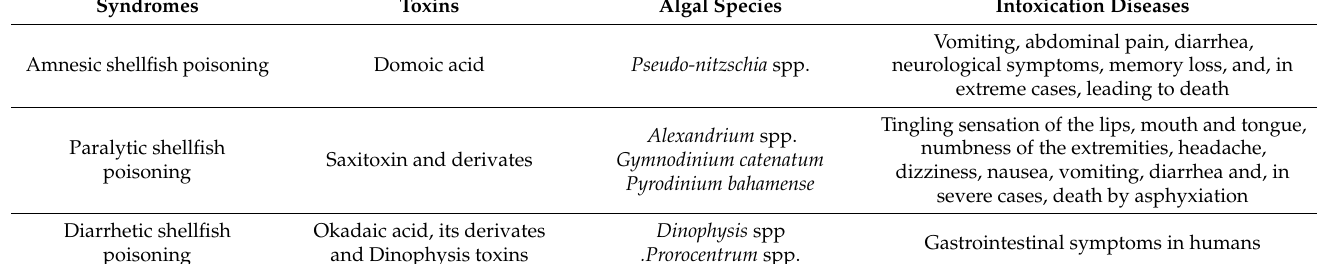
Table 1. Syndromes due to marine biotoxins, toxins, algal species and symptoms in humans and animal organisms.